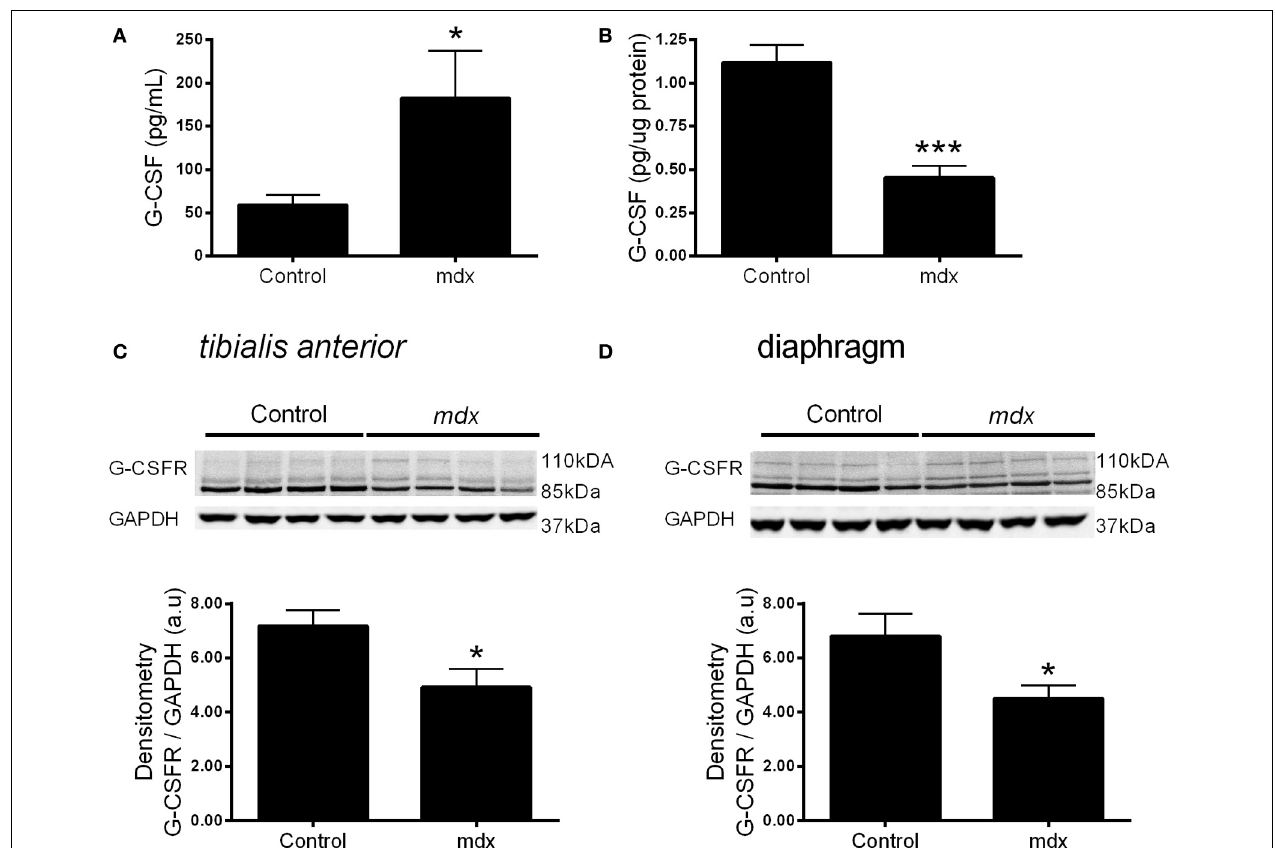
FIGURE 4 | G-CSF and G-CSFR protein expression in muscles from mdx mice. (A) Circulating plasma G-CSF levels. (B) G-CSF levels in the diaphragm homogenate. (C) Representative western blot images for the G-CSFR in the tibialis anterior muscle and band densitometry analysis and (D) Representative